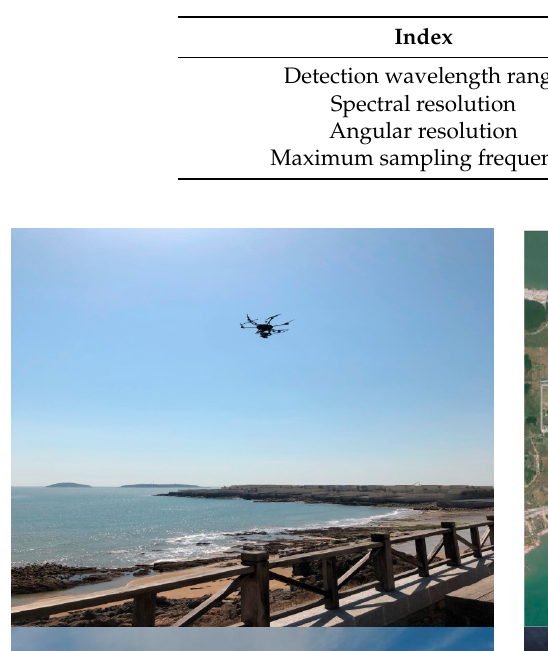
Table 1. Hyperspectral imager parameters.